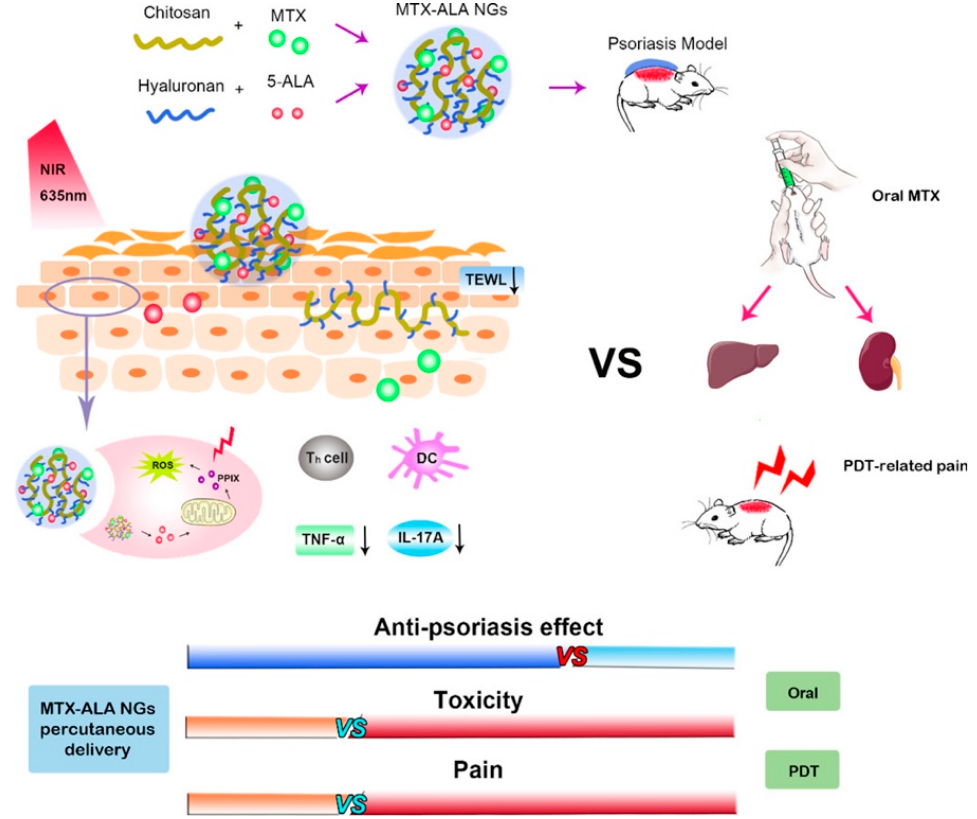
Figure 10. Schematic diagram of combined chemical-photodynamic treatment of psoriasis with MTX and ALA loaded CS/HA nanogels (NGs). MTX-ALA NGs promoted the penetration of both ALA and MTX into the skin, synergistically enhancing the local treatment of psoriasis and reducing the toxicity and pain associated with the photodynamic therapy of ALA and oral MTX [177]. Reproduced with permission from Yixuan Wang, Carbohydrate Polymers; published by Elsevier, 2022.